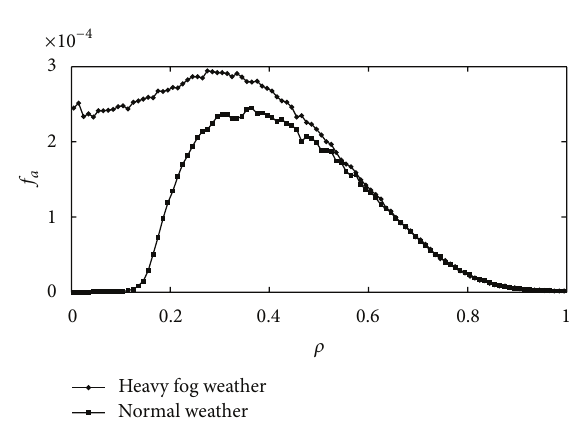
Figure 4: Relationship between 𝑓 𝑎 and 𝜌